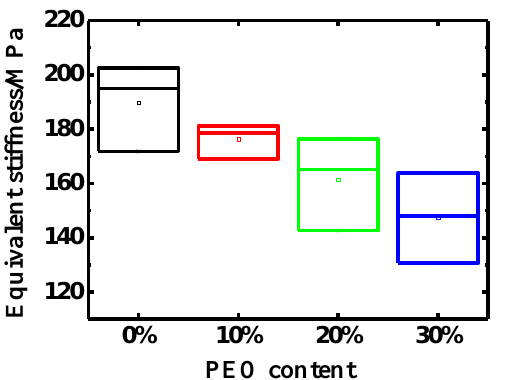
Figure 4. Equivalent stiffness of PEO/Nafion-IPMC with varying PEO contents.